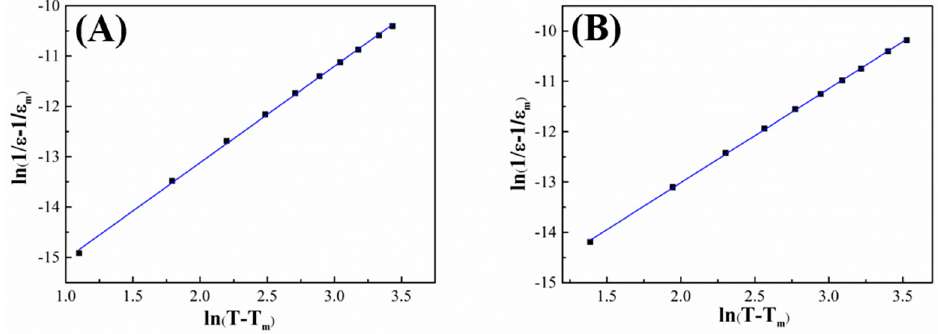
Figure 4. Reciprocal permittivity ( 1 ε − 1 ε (cid:2869) with a direction of [110] ( A ), and [111] ( B ).